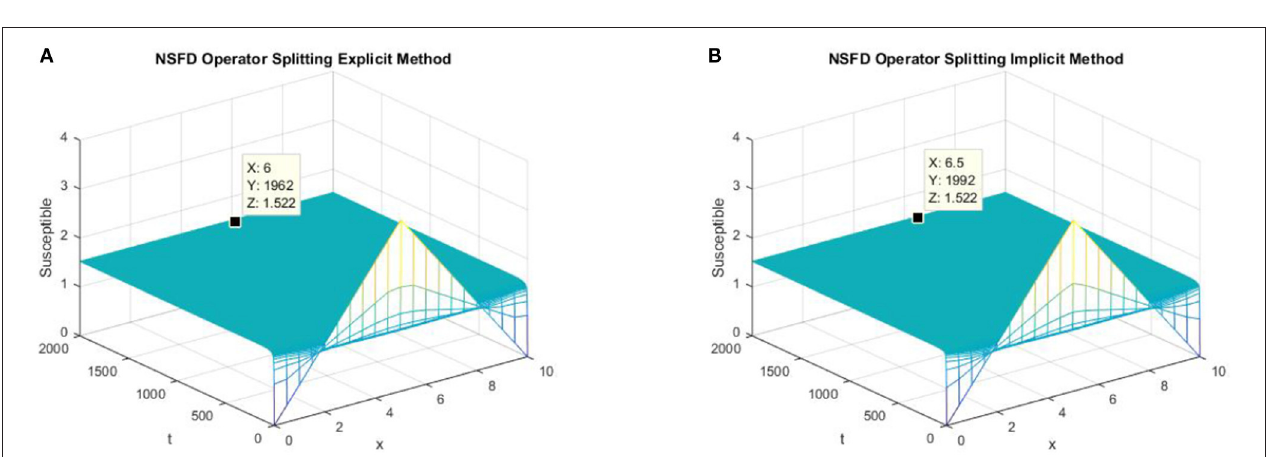
FIGURE 4 | (A) The explicit operator splitting NSFD method is used to simulate the graph of susceptible persons for the DFE point at h = 0.5, λ 1 = 0.3. (B) The implicit operator splitting NSFD method is used to simulate the graph of susceptible persons for the DFE point at h = 0.5, λ 1 = 0.4.